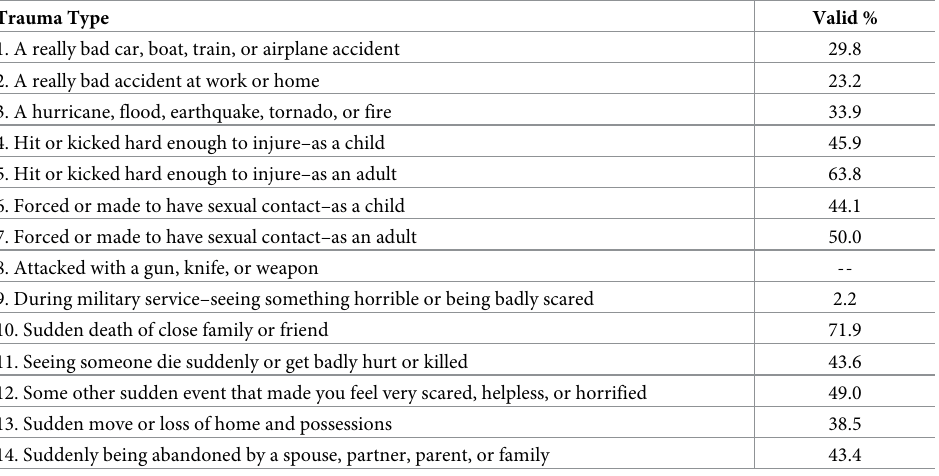
Table 5. Exposure to lifetime potential trauma in Phase 4 clinical sample ( N =